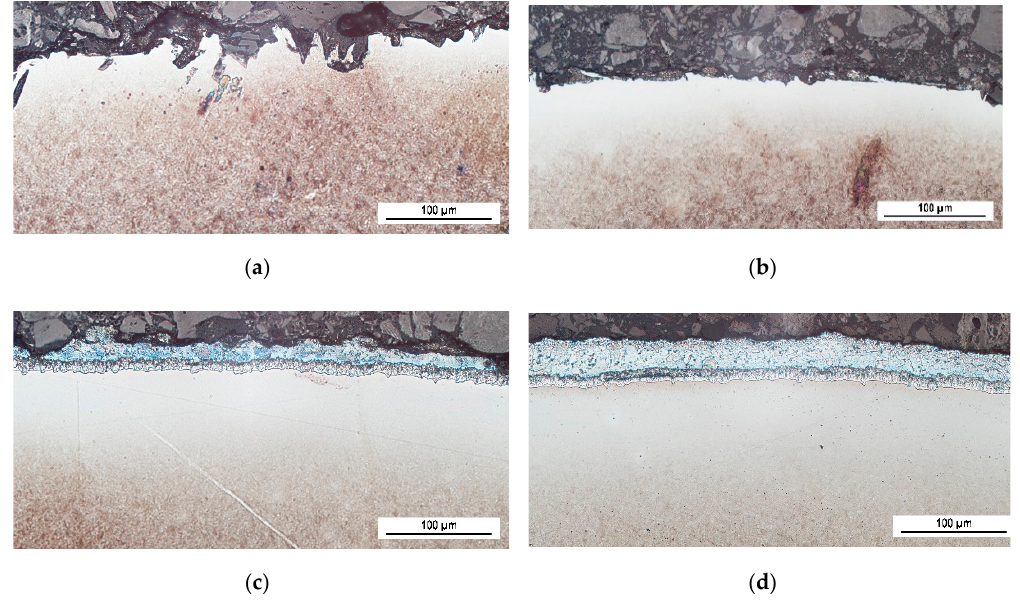
Figure 4. Metallographic images of galvanized wire surface—cross-sections: ( a ) position 1, ( b ) position 2, ( c ) position 3, ( d ) position 4.